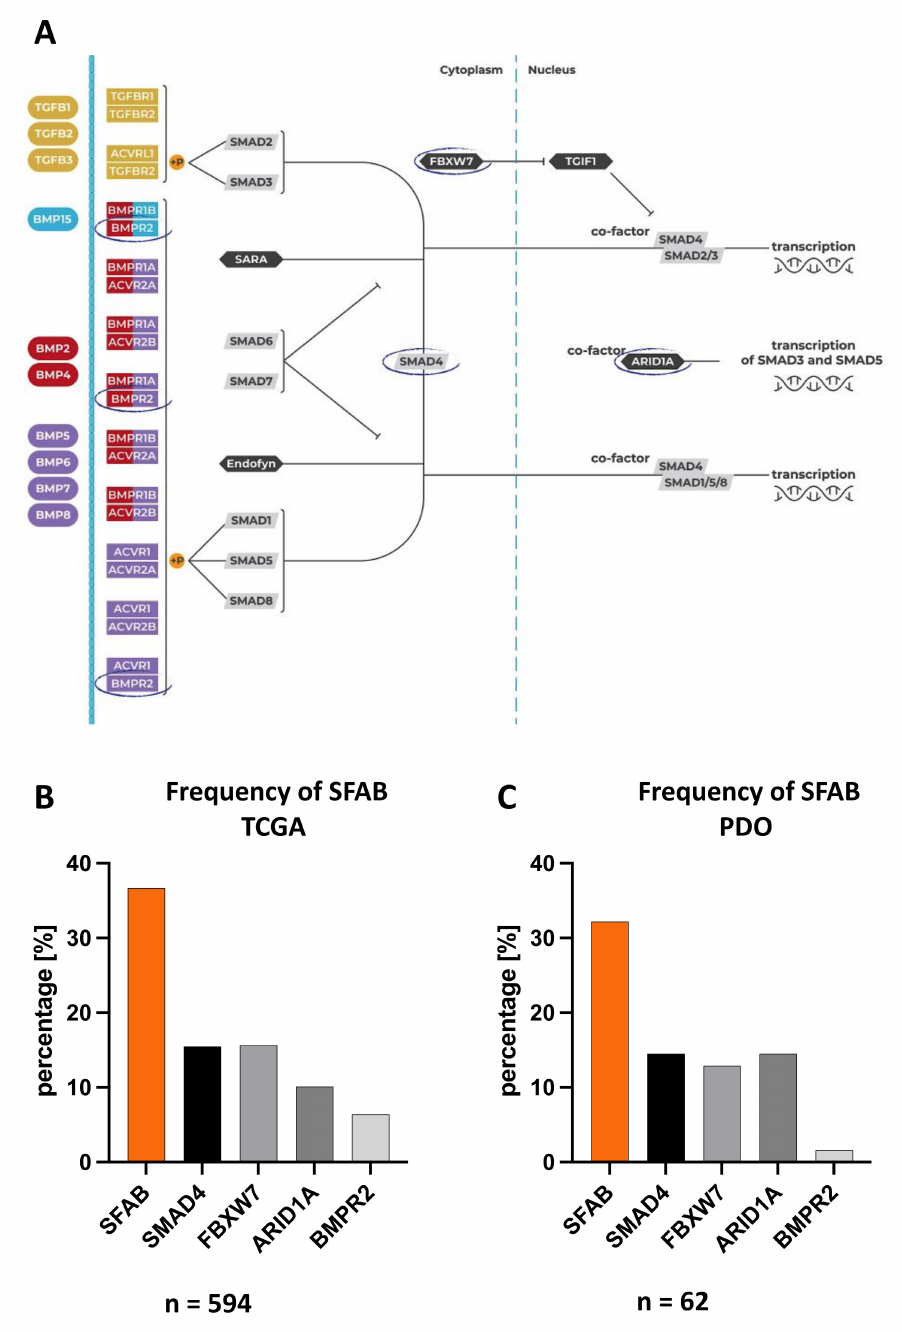
Figure 4. Four frequently mutated genes in CRC ( SMAD4 , FBXW7 , ARID1A, or BMPR2 ) are involved in the TGF- β /BMP pathway. ( A ) Scheme of the TGF- β /BMP pathway with four fre- quently mutated genes in CRC (circled): SMAD4 = mothers against decapentaplegic homolog 4, FBXW7 = F-box/WD repeat-containing protein 7, ARID1A = AT-rich interactive domain-containing protein 1A, BMPR2 = Bone morphogenetic protein receptor type II. ( B ) Frequency of SFAB ( SMAD4 , FBXW7 , ARID1A , or BMPR2 ) in CRC patients (TCGA = The Cancer Genome Atlas, PanCancer Atlas colorectal adenocarcinomas (n = 594) (https://www.cbioportal.org, accessed on 18 August 2021)). ( C ) Frequency of SFAB in CRC PDOs (n = 62). (See also Table